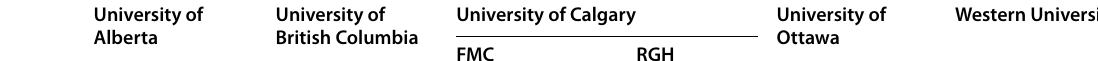
Table 2 Key features of 2021‑2022 internal medicine POCUS